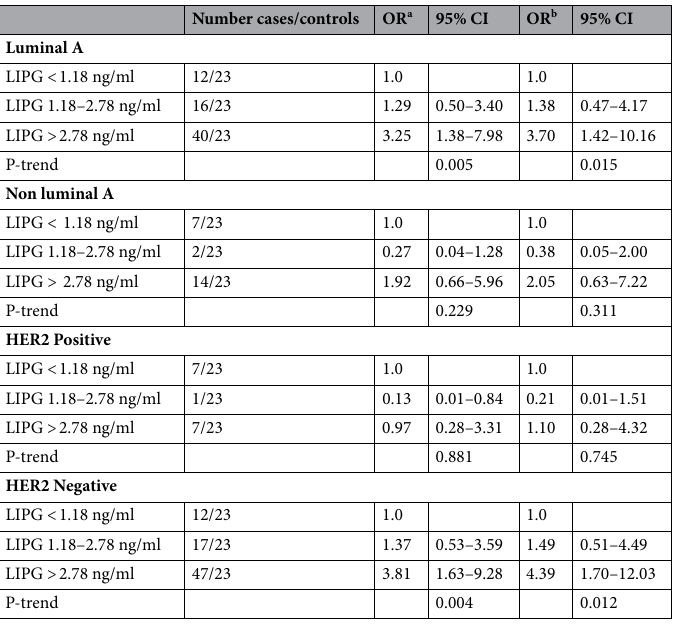
Table 4. LIPG and breast cancer risk by subtypes. a Adjusted for age at diagnosis (cases) and age at interview (controls). b Further adjusted for age at menarche, parity, menopausal status, BMI, and family history of breast/ ovarian